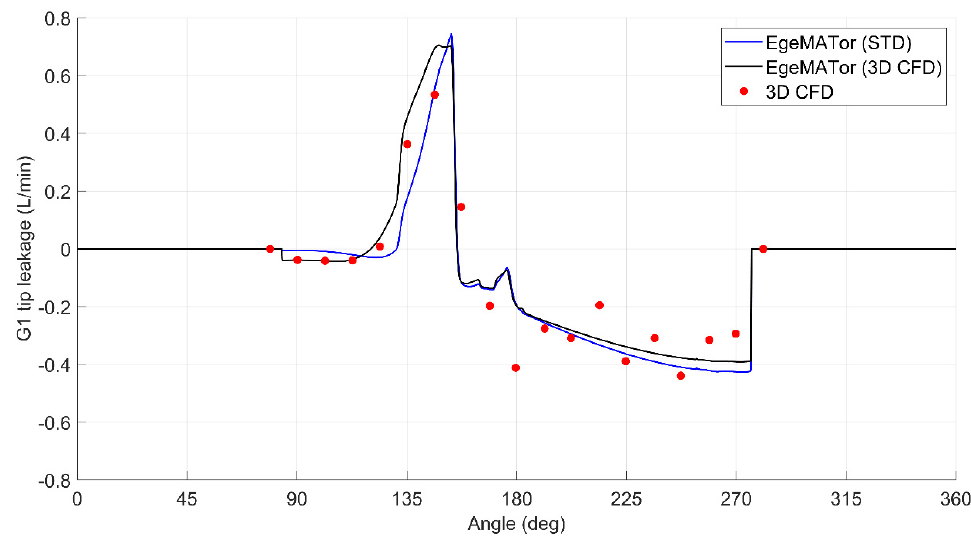
Figure 12. Tip leakage across driving tooth n°2 G 2 at 1500 rev/min and 350 bar.